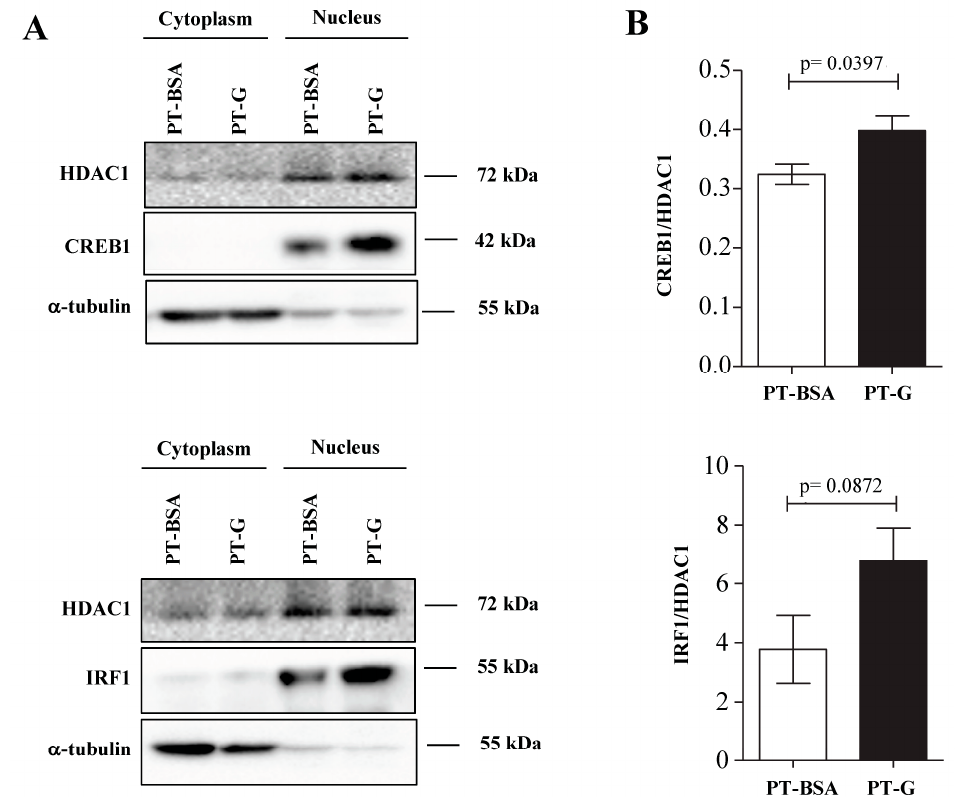
Figure 4. In vitro characterization of selected TFs. ( A ) The translocation of IFN regulatory factor-1 (IRF1) and CREB1 to the nucleus was analyzed by Western blot in 3 independent experiments upon stimulation with pepsin-trypsin digested gliadin (PT-G) or pepsin-trypsin digested BSA (PT-BSA) as control; ( B ) Band intensity was quantified and normalized to the intensity of the band corresponding to HDAC1. Mean values were compared with a t -test. Data are expressed as mean ± SEM.